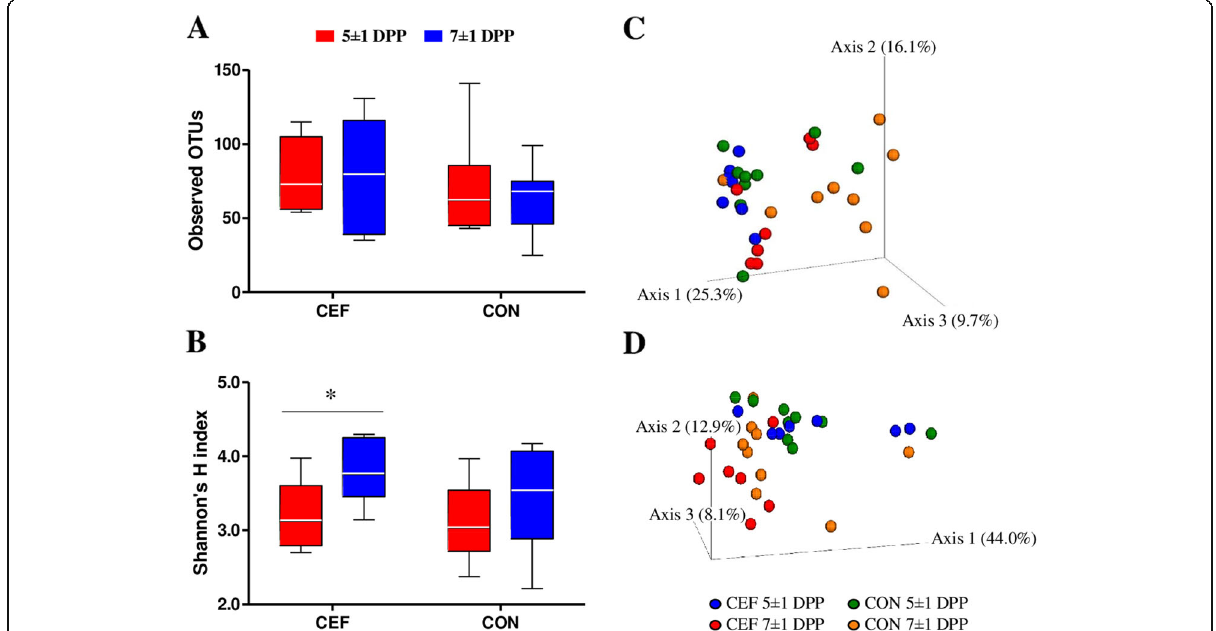
Fig. 1 Uterine microbiota diversity. a Observed OTUs (CEF: P = 0.75, CON: P = 0.72). b Shannon ’ s H index (CEF: P = 0.05 * , CON: P = 0.23). c Uterine microbiota on unweighted UniFrac (PERMANOVA, P < 0.01). d Uterine microbiota on weighted UniFrac (PERMANOVA, P = 0.01). Data in a and b present minimum, median (the line in the middle of the box), and maximum, and they were analyzed between 5 ± 1 DPP and 7 ± 1 DPP within the group using the Wilcoxon signed-rank test. Data in c and d present UniFrac distances between bacterial communities, and PERMANOVA was used to test dissimilarity between